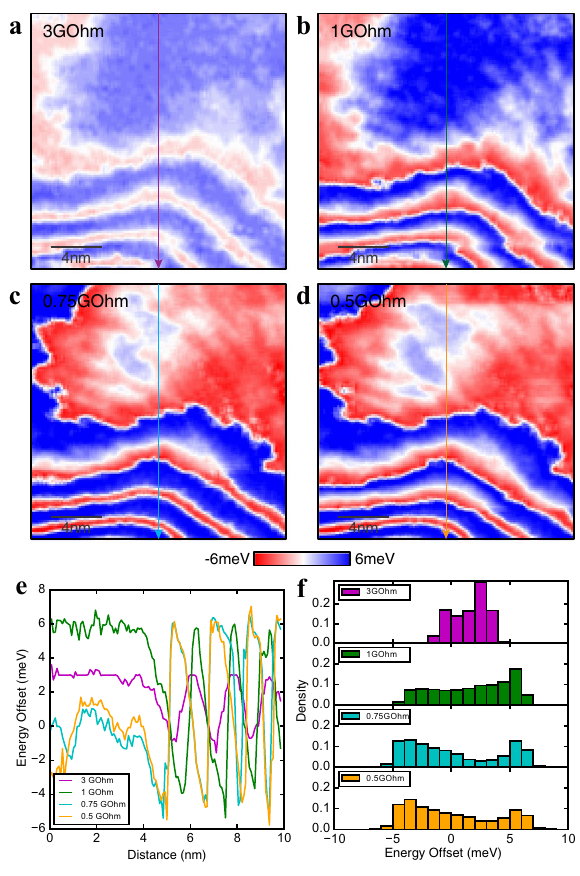
Figure 3. Energy offsets at different junction resistances. ( a–d ) Energy offset maps at 3GOhm, 1GOhm, 0.75GOhm and 0.5GOhm junction resistance in the same FOV. Red (blue) represents spectral shift toward negative (positive) energies. ( e ) Line cuts through the same vertical lines from a, b, c, and d. Magnitudes and phase differences are strongly junction resistance dependent. ( f ) Energy offset distributions of all four junction resistances maps. The energy offsets tend to be larger when junction resistance is smaller, which means tip is closer to the